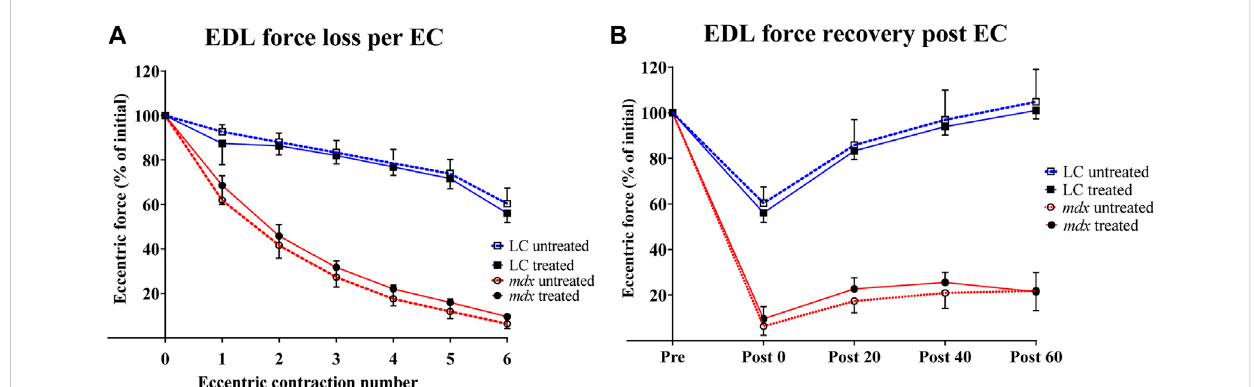
FIGURE 3 Percentage force loss and force recovery from EC protocol (A) Percentage force loss resulting from a series of six ECs at 20% stretch at 2.4 mm/s from Lo ( n = 6). Force was normalized to the isometric plateau of the fi rst EC in each group (B) Percentage force recovery recorded at 0, 20, 40, 60